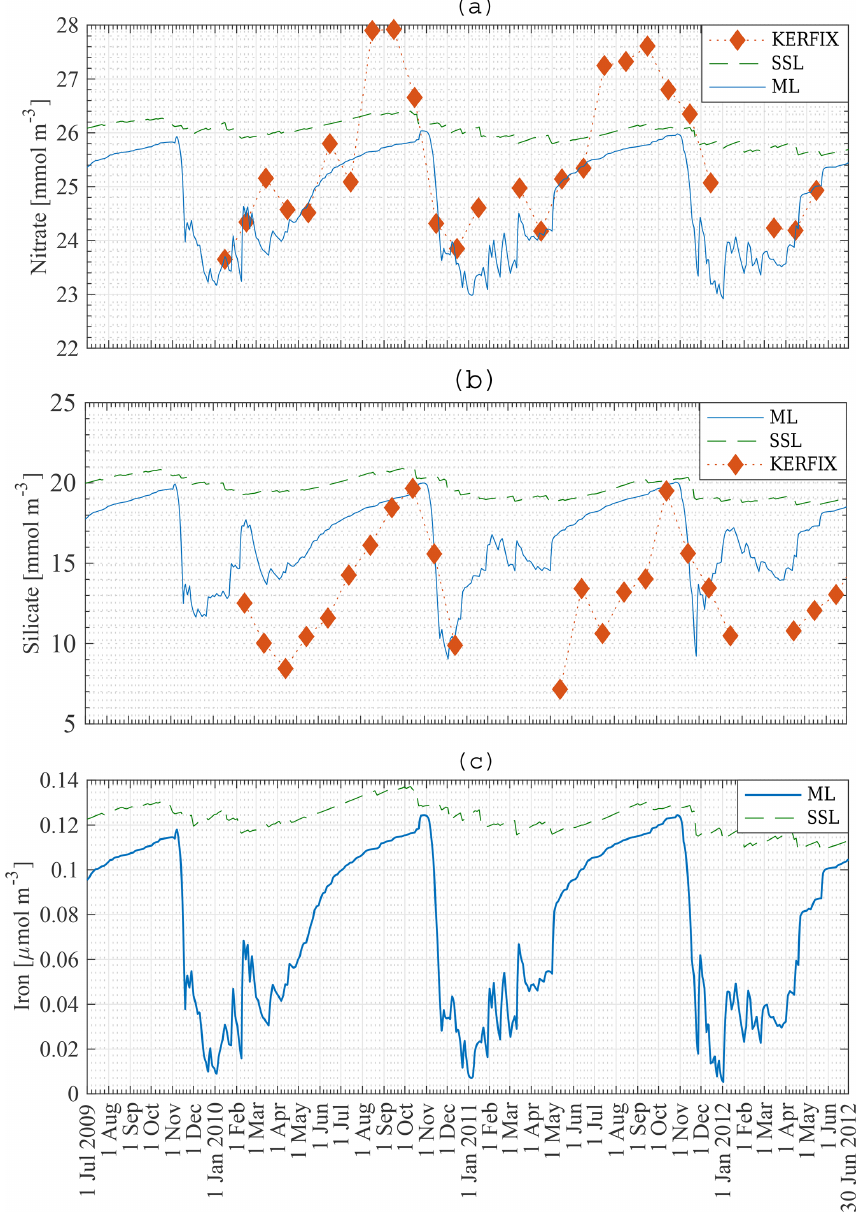
Figure 8. Model result: nitrate (a) , silicate (b) and iron (c) concentration in the mixed layer (solid line) and in the subsurface layer (dashed line) compared to KERFIX in situ data ( (cid:7) ) at station 18 from 1 July 2009 to 30 June 2012. KERFIX in situ data from January 1992 to June